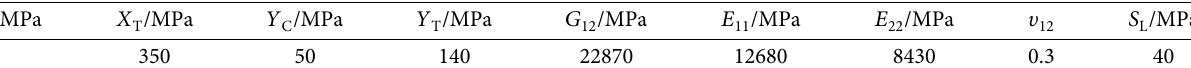
Figure 1: Section form of the GFRP tube flled with reinforced hollow concrete Table 1: Properties of the unidirectional GFRP tube.